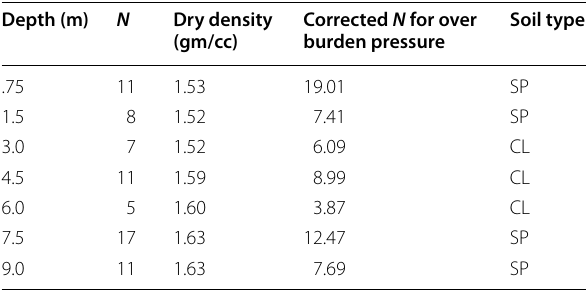
Table 1 Results of a standard penetration test at Roorkee